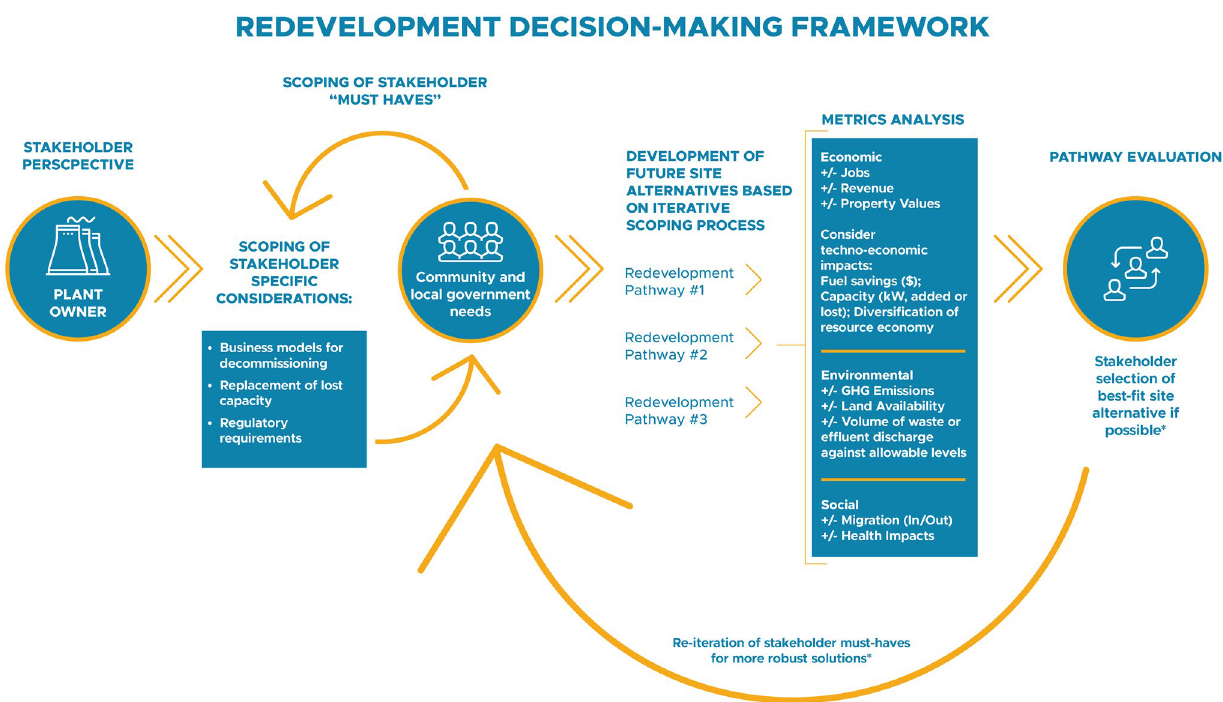
Fig. 4 Redevelopment decision-making